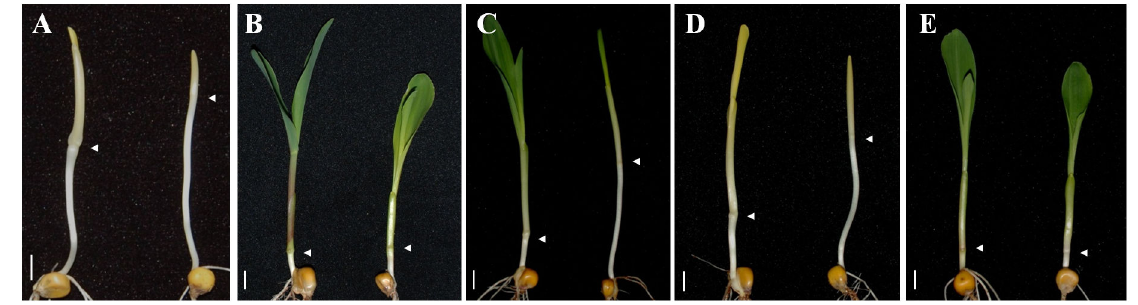
Figure 2. De-etiolation responses in Zheng58 wild-type plants and elm2 mutants. Representative seedlings were photographed after 7 d of growth in continuous darkness (A), white light (B), red light (C), far-red light (D) or blue light (E) conditions. Left, Zheng58 wild-type seedlings; Right, elm2 mutants. Scale bar=1 cm.